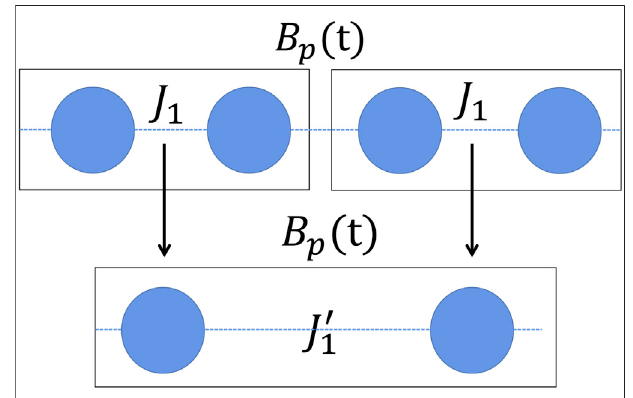
FIGURE 1 | The procedure of the 1D model